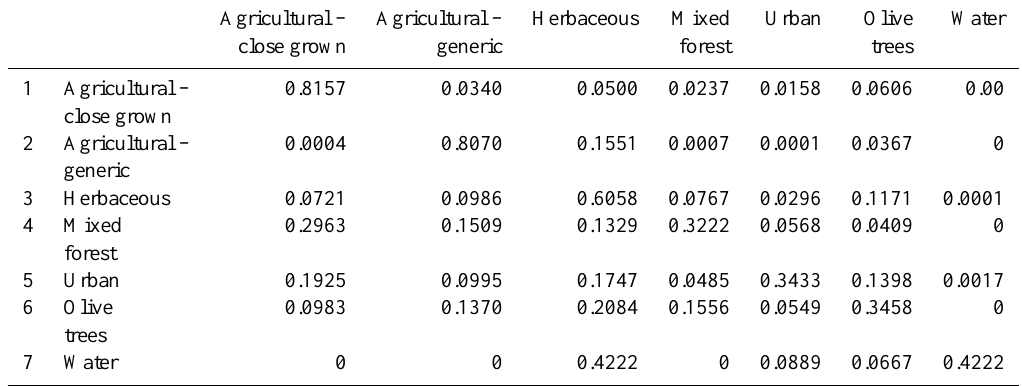
Table 2. Transition probability matrix for each land cover class using the Markov chain